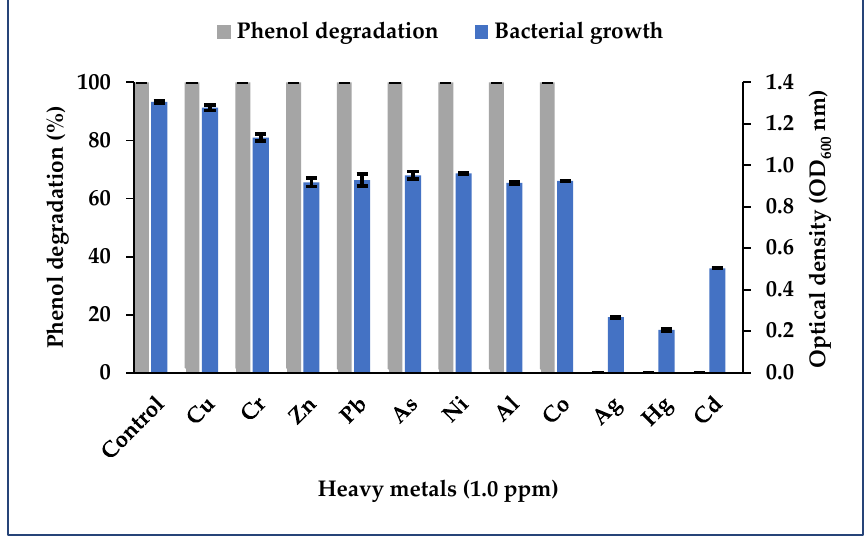
Figure 7. Phenol degradation and growth of Arthrobacter sp. strain AQ5-15 in the presence of 1.0 ppm concentrations of different heavy metals. Error bars represent the mean ± standard deviation of three replicates.